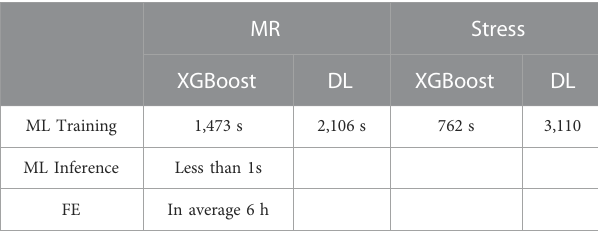
TABLE 2 Runtime (CPU) for FE and ML results.